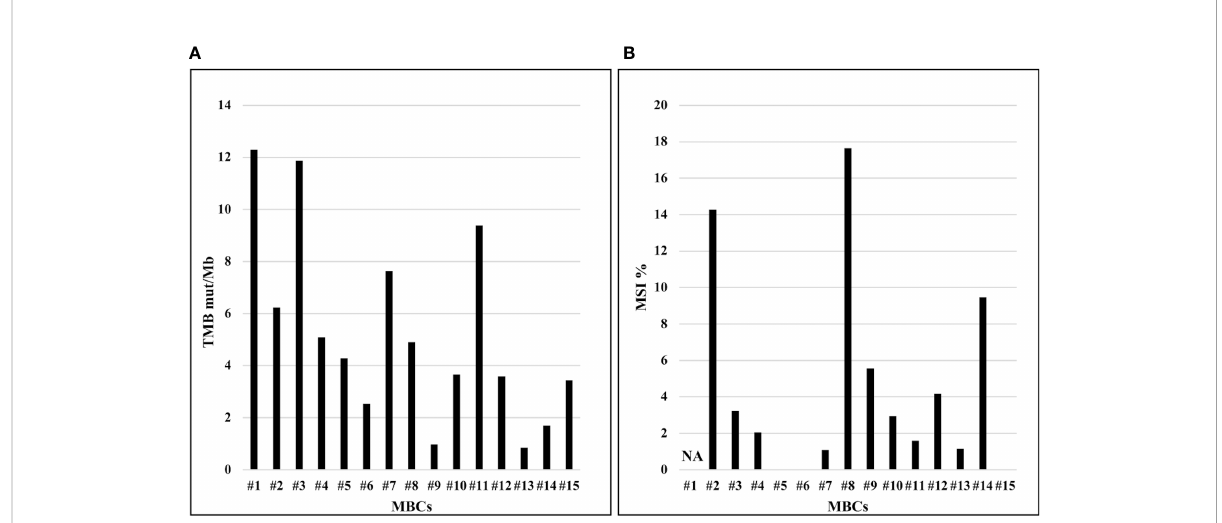
FIGURE 3 TMB (mut/Mb) and MSI (%) of MBCs analyzed. (A) Distribution of TMB (y-axis), by sample. (B) Distribution of MSI (y-axis), by sample. NA, not